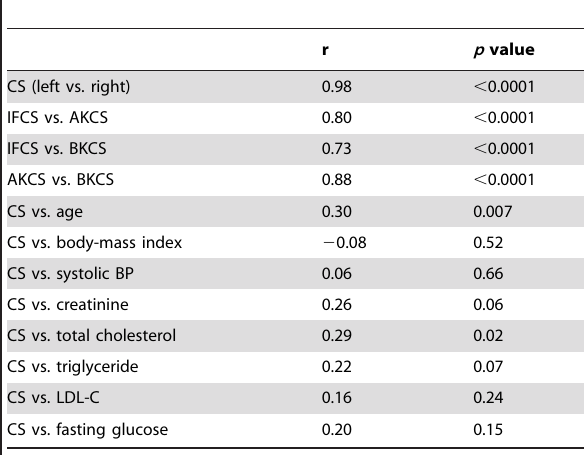
Table 2. Correlation between segmental calcium scores (CS) and biochemical parameters.